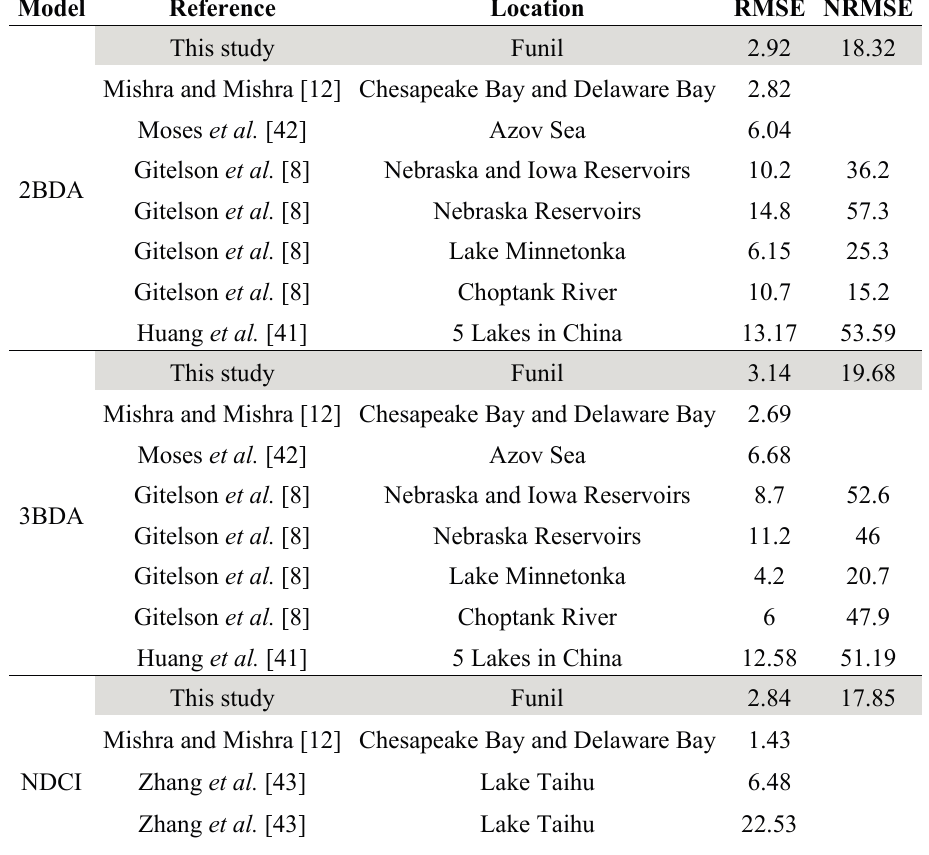
Table 11. Comparison of error estimators values from other